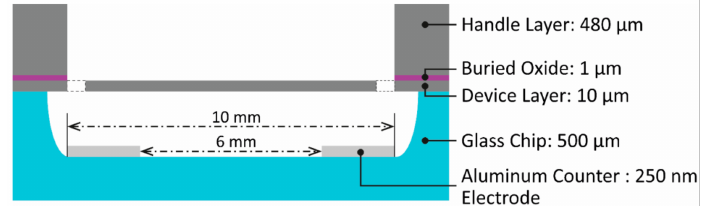
Figure 4. Schematic cross-sectional view of the bonded device made up of the device chip ( top ) and the glass carrier chip ( bottom